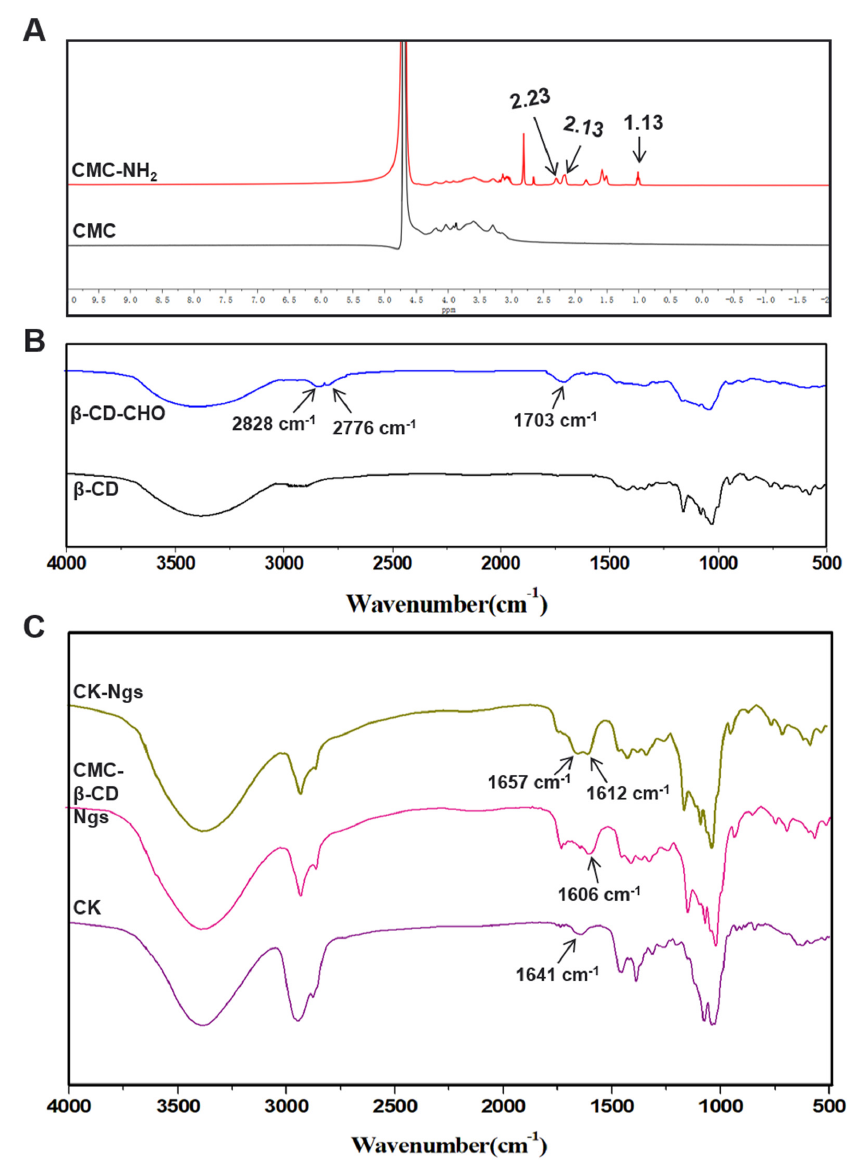
Figure 3. Characterization of modified materials and synthetic materials. ( A ) 1 H NMR spectra of CMC and CMC-NH 2 . ( B ) Fourier transform infrared (FTIR) spectra of β -CD and β -CD-CHO. ( C ) FTIR spectra of CK, CMC- β -CD Ngs and CK-Ngs.